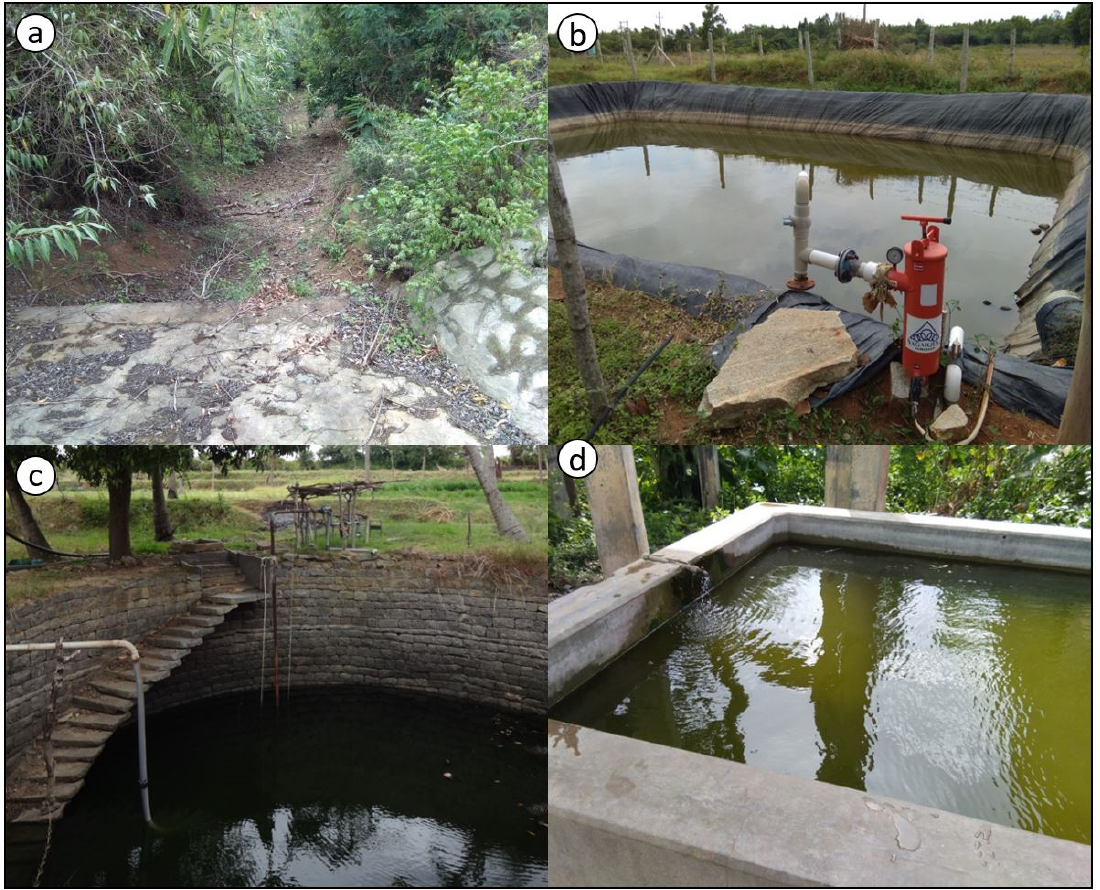
Figure 3. Water-holding structures created and encouraged as part of WSD projects: ( a ) check dam (without water); ( b ) farm pond (with tarpaulin lining); ( c ) open well; and ( d ) water trough for cattle (source: first author; images captured during transect walks in study villages).